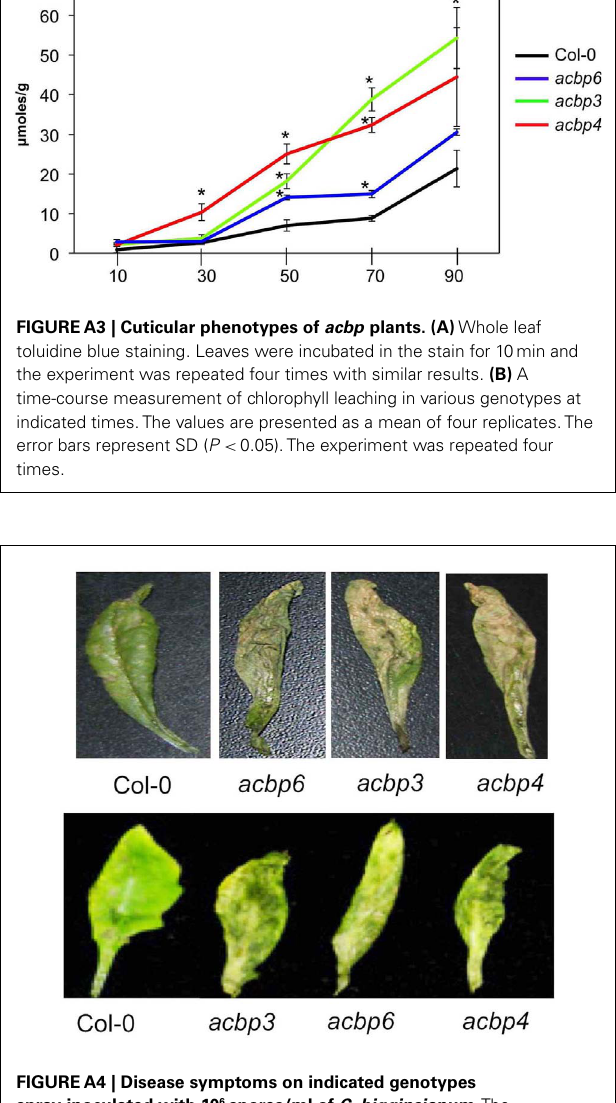
FIGUREA4 | Disease symptoms on indicated genotypes spray-inoculated with 10 6 spores/ml of C. higginsianum . The experiment was carried out five times, three of which showed enhanced susceptibility in acbp plants, while the remaining two showed wild-like infection phenotypes on acbp plants.The upper and lower panels show two independent experiments that showed enhanced susceptibility in acbp